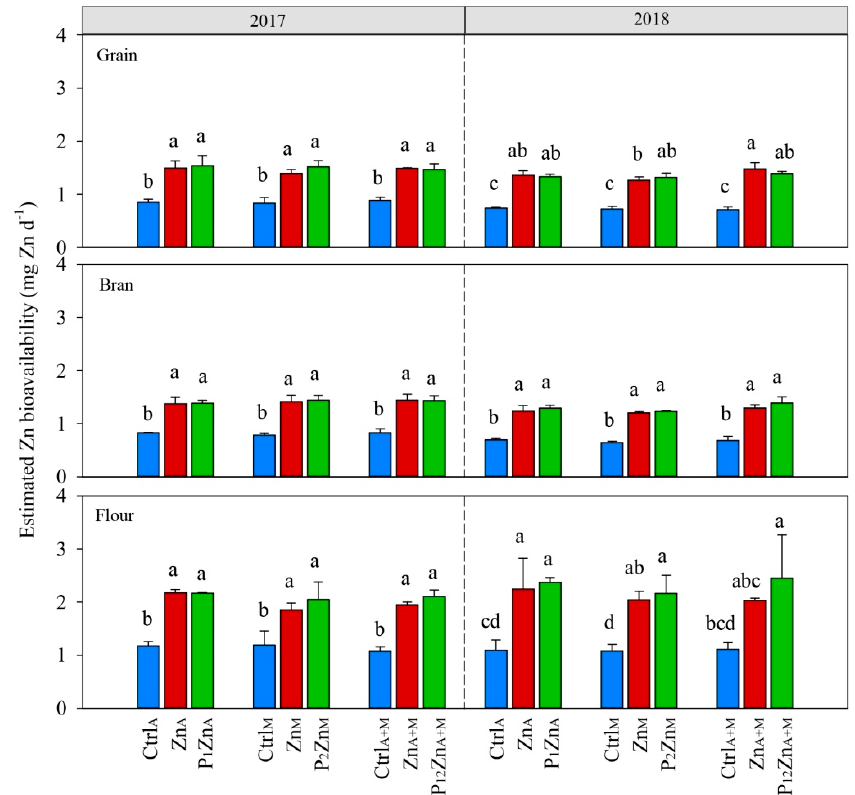
Figure 7. The estimated Zn bioavailability in whole-grain and its milling fractions (bran and flour) of wheat harvested in 2017 and 2018. Treatments consisted of nil Zn spray (control, Ctrl) and foliar Zn application alone (Zn) or plus pesticides (PZn) at the anthesis (A), milk stage (M) or both (A+M). Pesticides were a mixture of fungicide + insecticide which were thiophanate-methyl + beta-cypermethrin at anthesis (P 1 ZnA) and triadimefon + imidacloprid at milk stage (P 2 ZnM). Vertical bars represent the standard error of four replications. Columns with no letter in common indicate significant differences between treatments each year by LSD test ( p < 0.05).